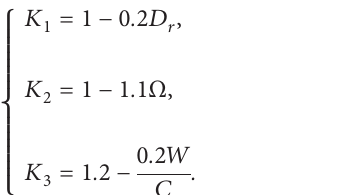
Figure 8: The sand grain-size distribution curve in a certain area of a